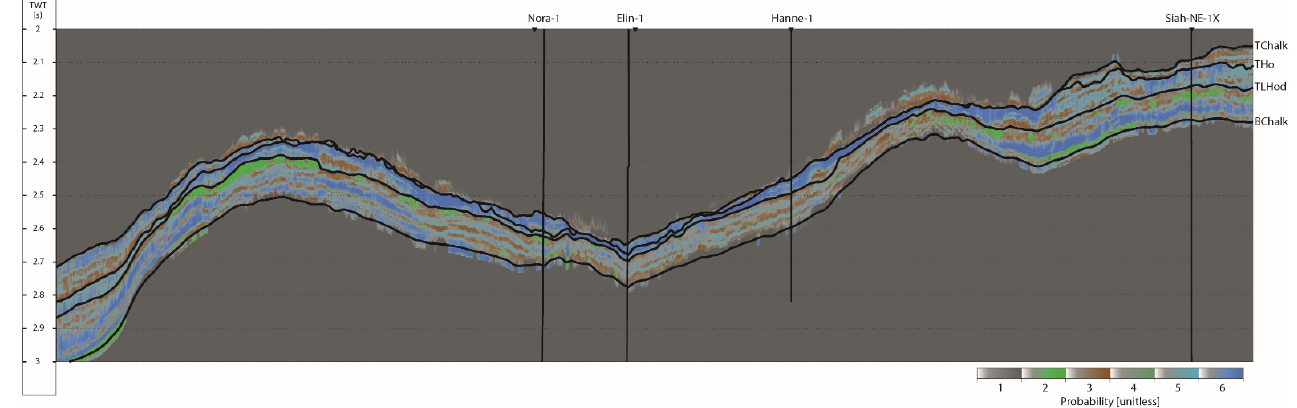
Figure 16. Direct probabilistic inversion result along the composite line. The individual colors represent the most likely geological facies’ inverted for (see Figure 6) and is from left to right: (1) shale, (2) high-porosity chalk with oil, (3) high-porosity chalk with brine, (4) medium-porosity chalk with oil, (5) medium-porosity chalk with brine and (6) low-porosity chalk. Well trajectories intersected by the composite line are displayed as black lines. The four seismic surfaces used are plotted in black.